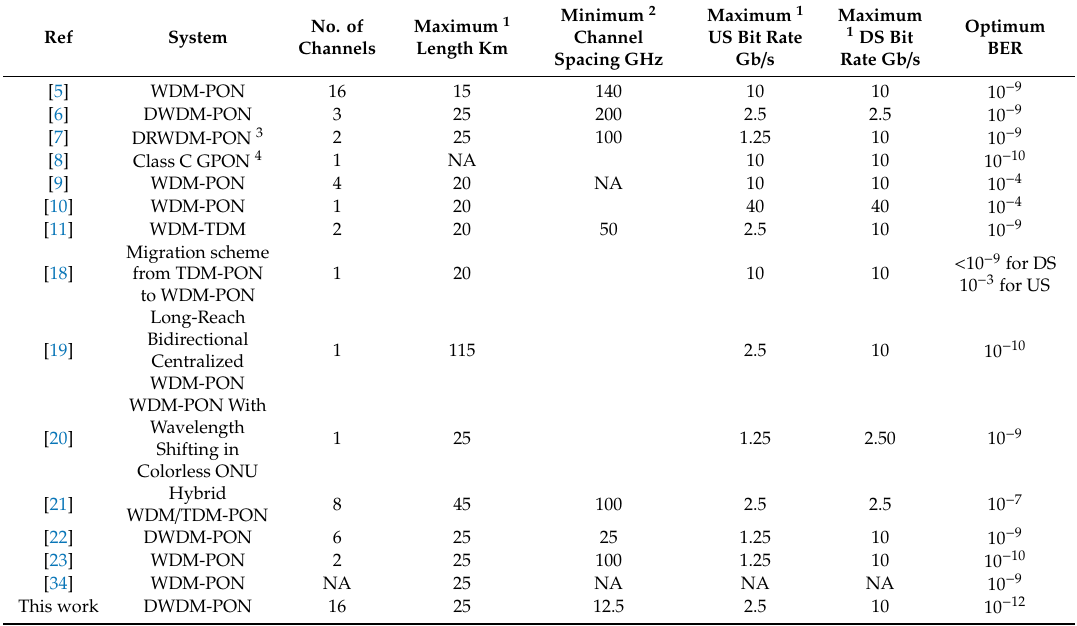
Table2. Acomparisonbetweenthestudiesandthepresentedworkfordi ff